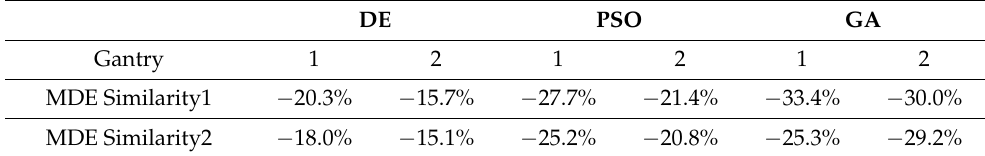
Figure 19. Learning curve regarding the number of picks. Table 5. The difference of the number of picks. Table 5. The difference of the number of